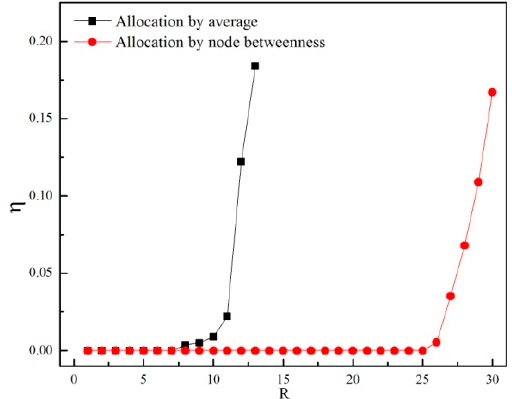
Figure 10. The order parameter η vs. R with different allocations of node resources under the shortest path routing. path